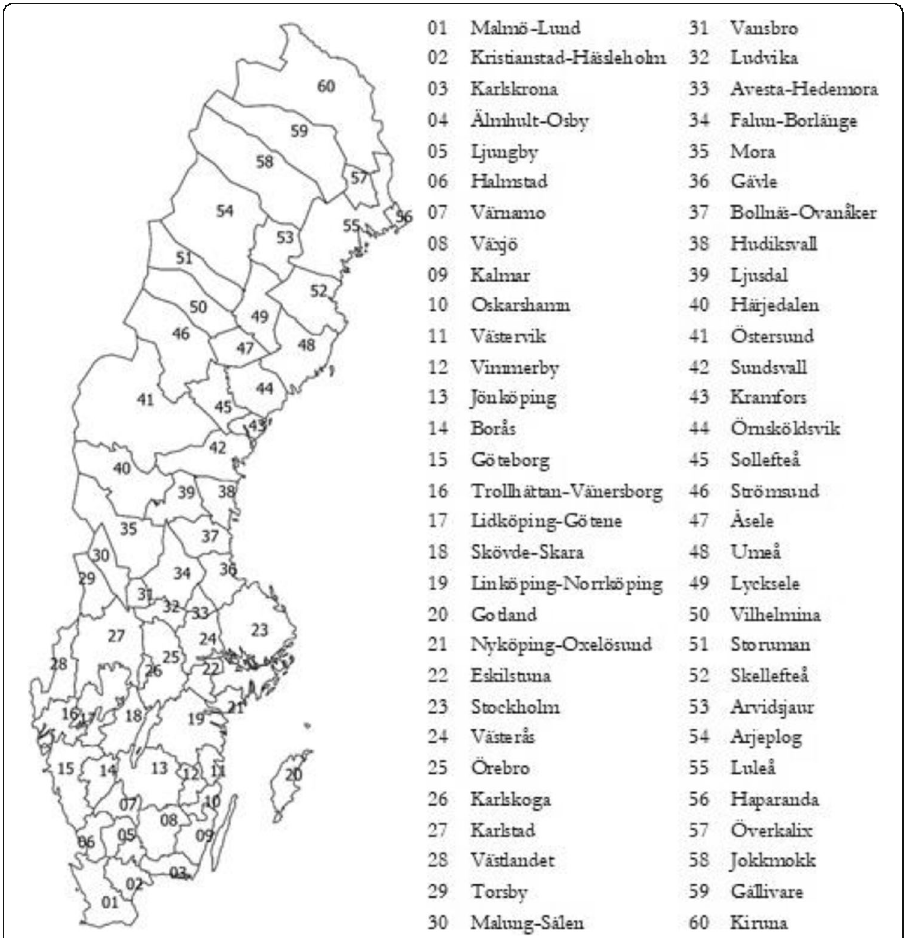
Fig. 1 Functional analysis regions in Sweden (FA2015-classification). Source: Swedish Agency for Economic and Regional